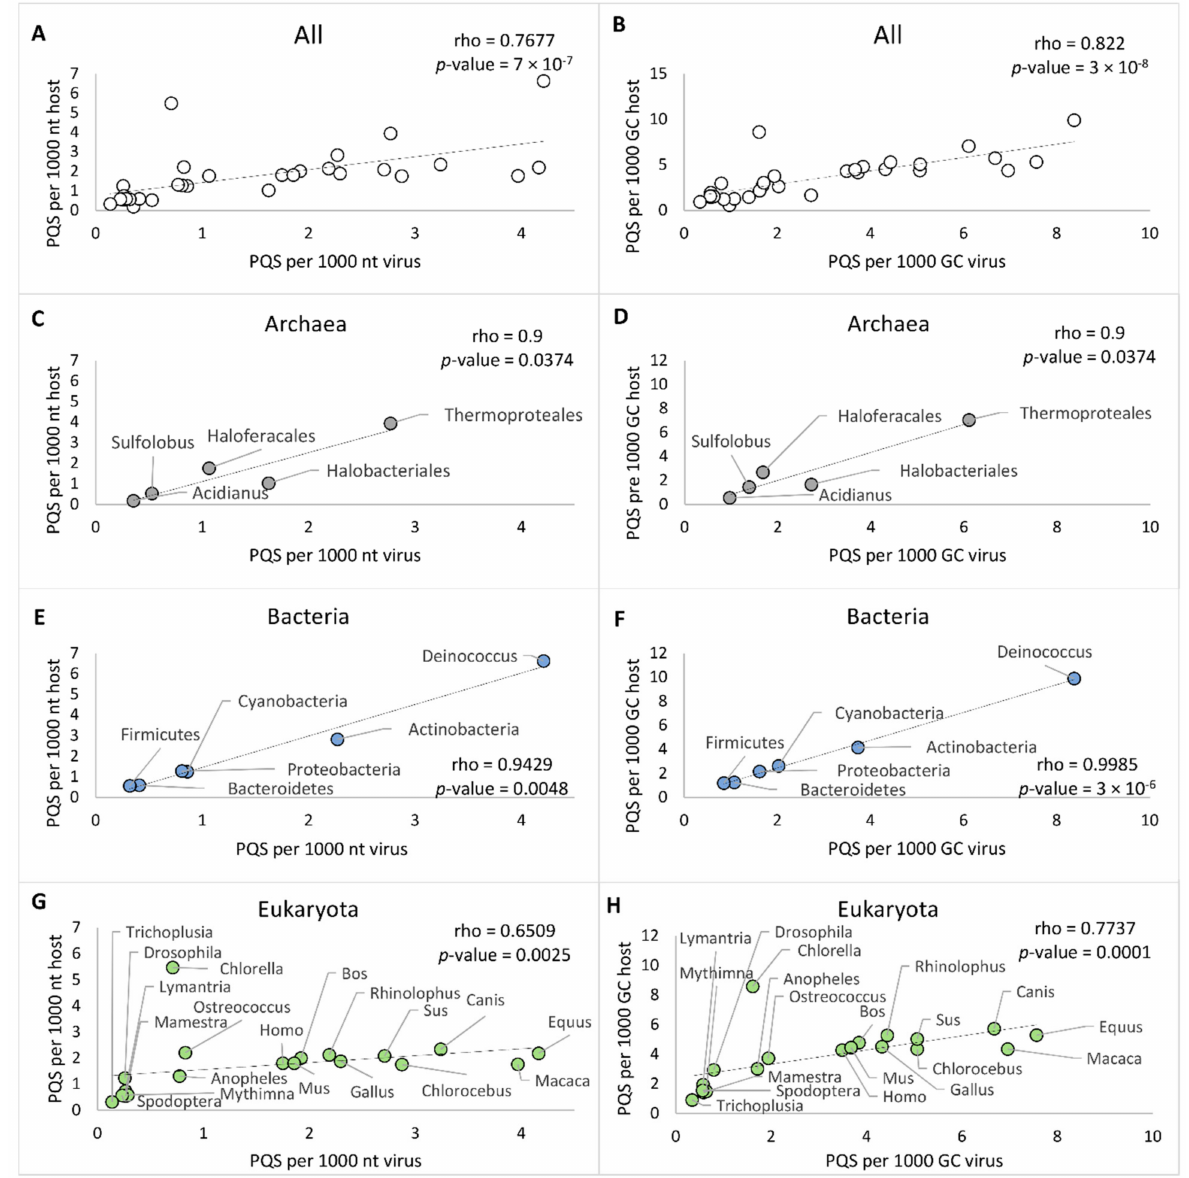
Figure 5. Relationships between virus and various hosts as measured by observed PQS frequency per 1000 nt and PQS frequency per 1000 GC. ( A ) All host-virus pairs, PQS frequencies; ( B ) All host–virus pairs, PQS per 1000 GC; ( C ) Archaea– virus pairs, PQS frequencies; ( D ) Archaea–virus pairs, PQS per 1000 GC; ( E ) Bacteria–virus pairs, PQS frequencies; ( F ) Bacteria–virus pairs, PQS per 1000 GC; ( G ) Eukaryota–virus pairs, PQS frequencies; ( H ) Eukaryota–virus pairs, PQS per 1000 GC of the archaea–virus